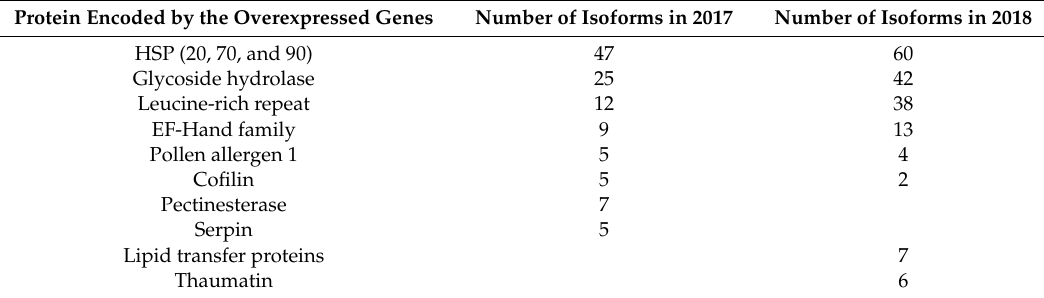
Table 3. Protein encoded by the overexpressed genes in Madrid pollen